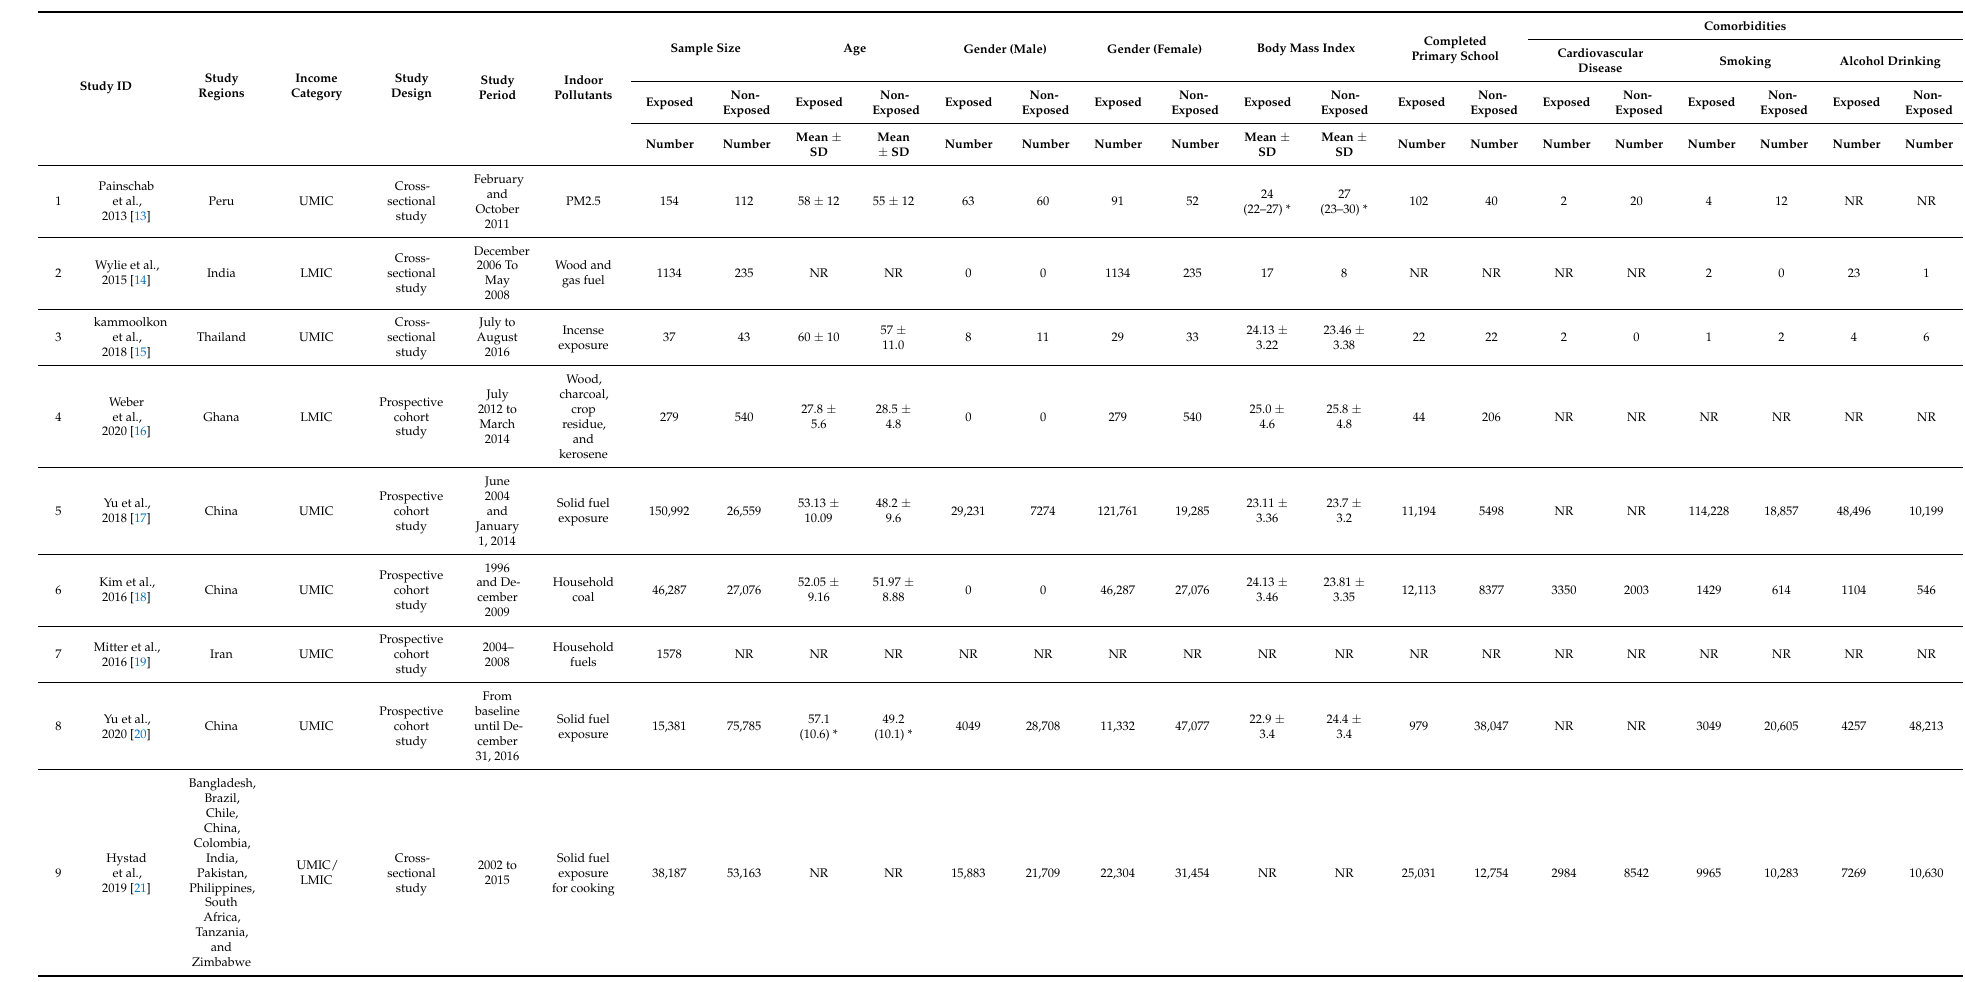
Table 1. Demographic characteristics of the included